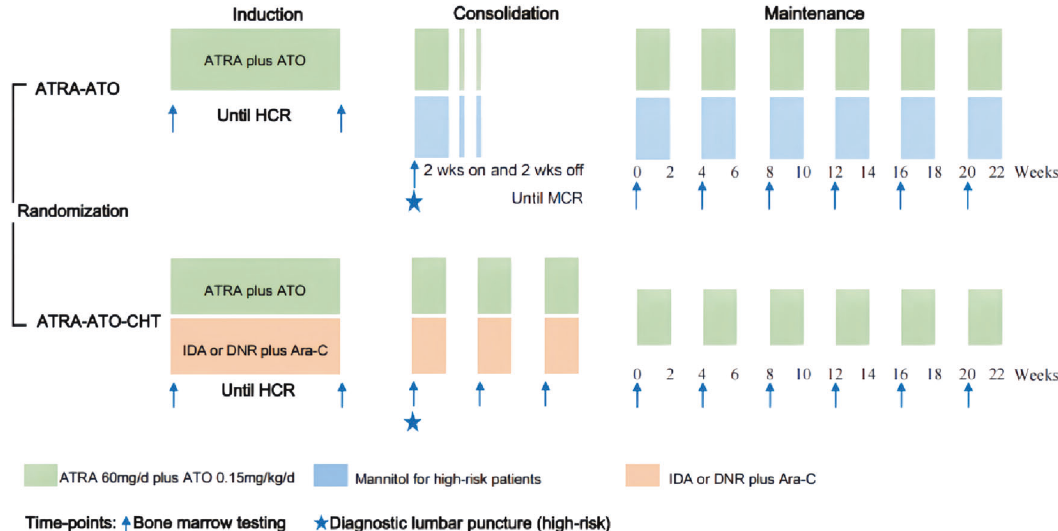
Fig. 1 Study design. ATRA all-trans retinoic acid. ATO arsenic trioxide, CHT chemotherapy, HCR hematological complete remission, MCR Molecular complete remission. In the ATRA-ATO group, synchronous administration of mannitol and ATO was used to prevent central nervous system leukemia in high-risk patients. In the ATRA-ATO-CHT group, the chemotherapy regimen was as follows: IDA (idarubicin) at a dose of 8 mg/m 2 /day on days 2, 4, 6 or DNR (daunorubicin) at a dose of 45 mg/m 2 /day on days 2, 4, 6, 8 plus Ara-C(cytosine arabinoside) at a dose of 150 mg/m 2 /day on days 1-7. The bone marrow testing included morphology and molecular